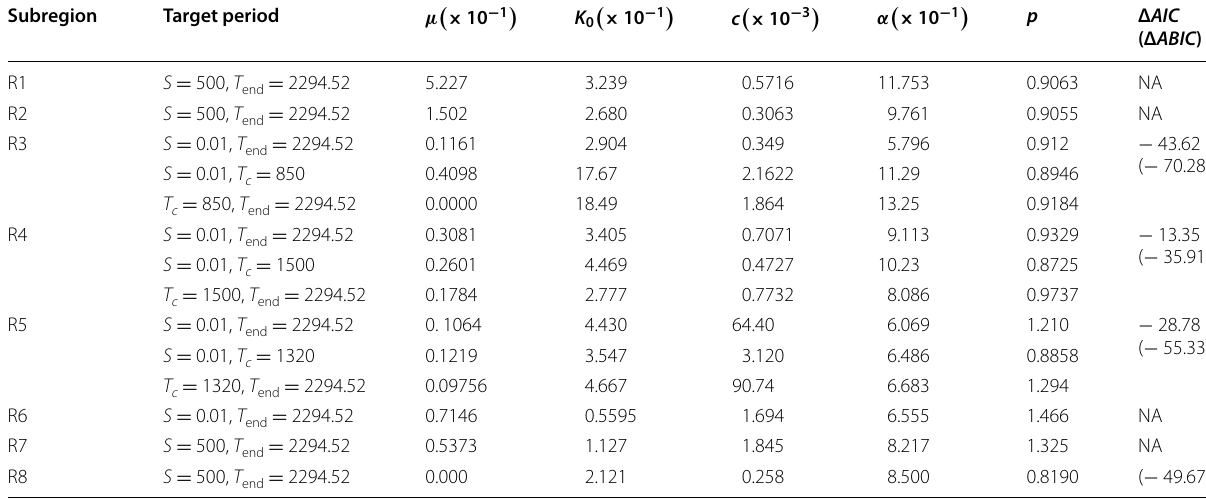
For the R3–R5 subregions, the first row shows the MLE estimates of the parameters for the entire period between S AIC AIC 0 , the second row shows those for the pre-change-point period ( S , T c ) with AIC = T end ) with AIC AIC 2 . The last column shows ΔAIC =